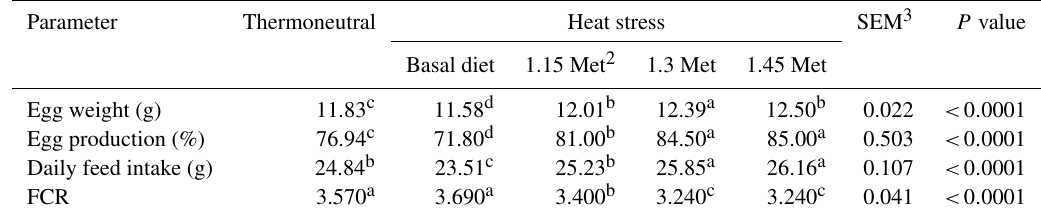
Table 2. Effect of methionine on egg weight, egg production, daily feed intake and FCR 1 in breeder quails. Parameter